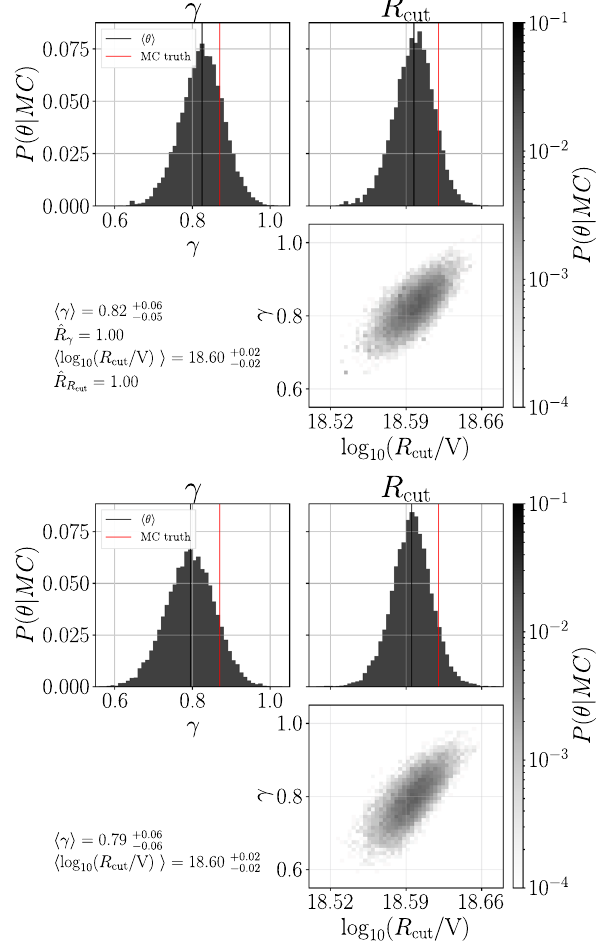
Fig. 5 Posterior distributions obtained with the MCMC (upper) and the cINN (lower) methods of the spectral index γ and the rigidity cutoff log 10 ( R cut / V ) . The mean of the distributions is shown by the black solid curve and the true underlying value of the benchmark simulation ismarkedbytheredcurve.Inthelowerleftoftheplotsofbothmethods, the mean and standard deviation of both parameters are shown, and for the MCMC also the Gelman–Rubin index ˆ